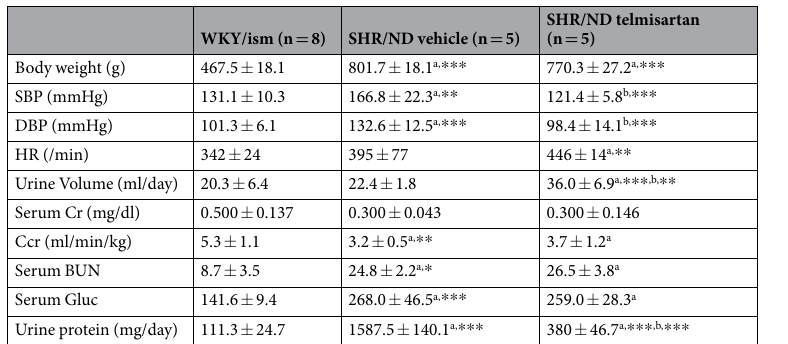
Table 2. Physiological data of WKY/ism and SHR/ND rats at 38 weeks of age. a WKY vs, b SHR/ND (vehicle) vs, * p < 0.05, ** p < 0.01, *** p <